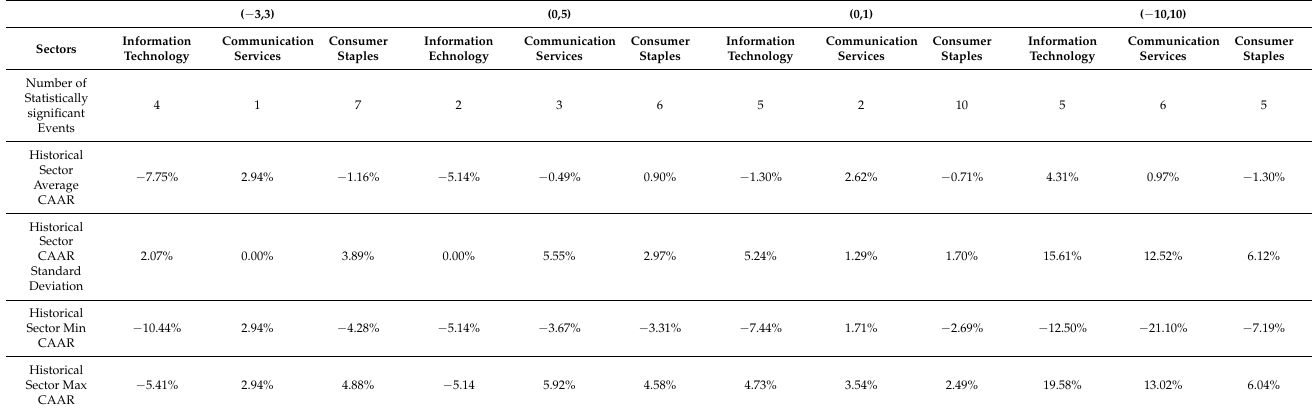
Table 2. Summary of Historical Sector cumulative and average CAAR results for all events